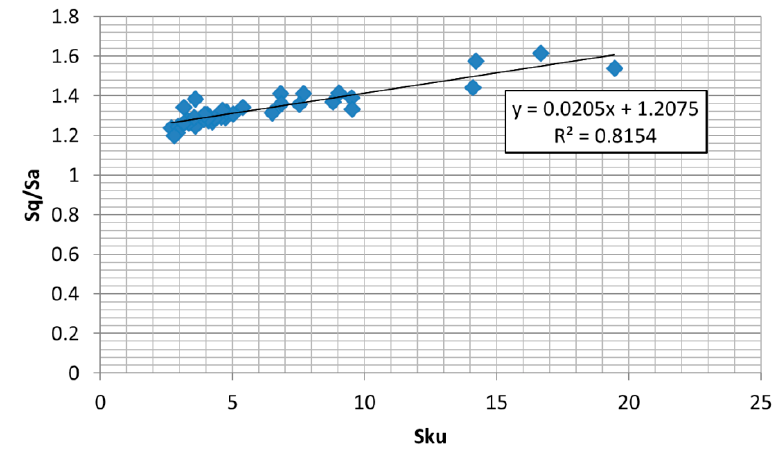
Figure 7. Dependence between parameters Sku and Sq/Sa.